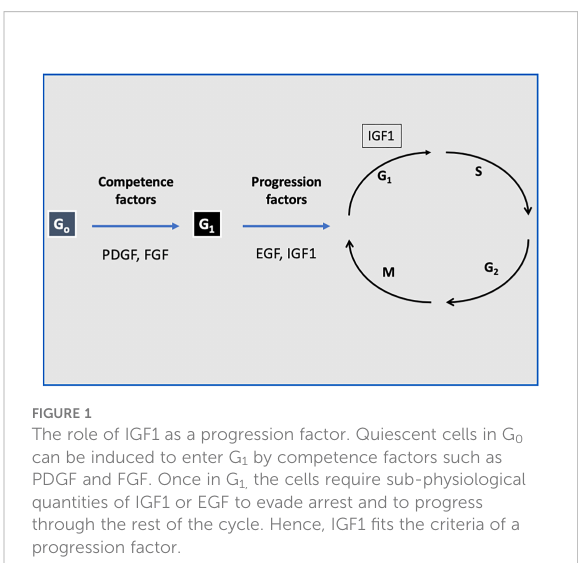
FIGURE 1 The role of IGF1 as a progression factor. Quiescent cells in G 0 can be induced to enter G 1 by competence factors such as PDGF and FGF. Once in G 1, the cells require sub-physiological quantities of IGF1 or EGF to evade arrest and to progress through the rest of the cycle. Hence, IGF1 fi ts the criteria of a progression